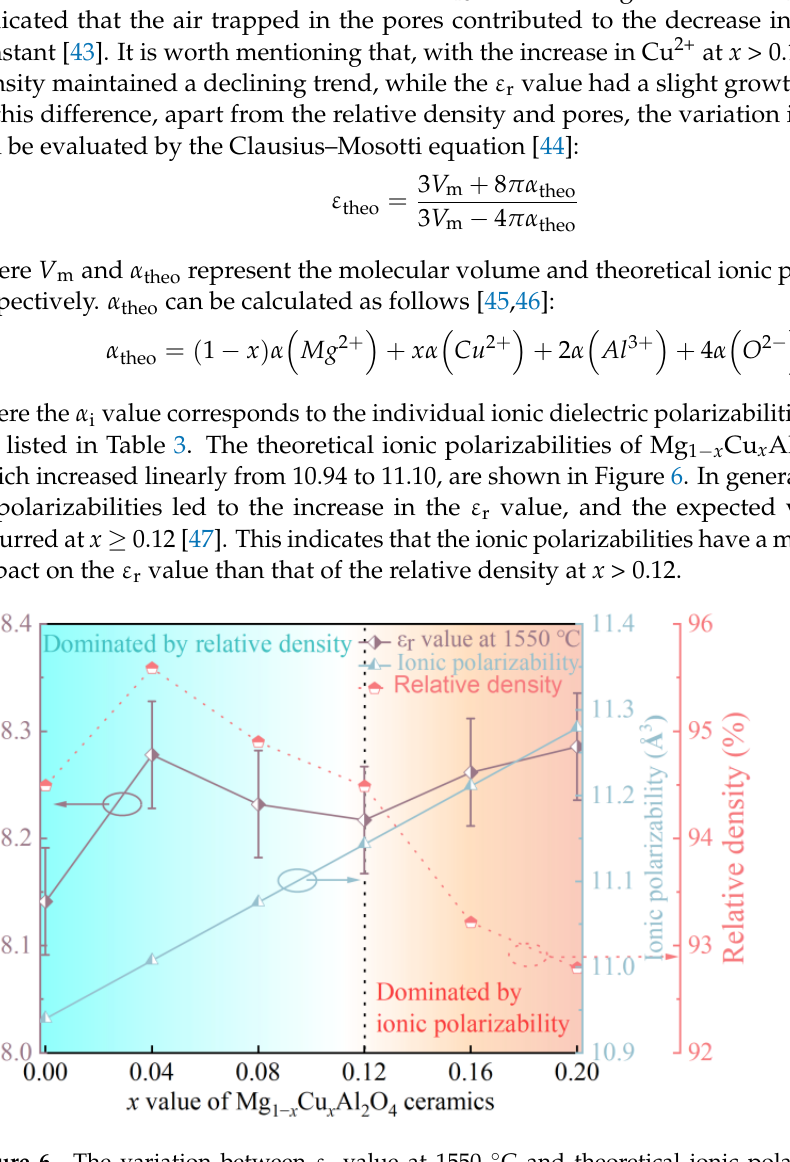
Figure 6. The variation between ε r value at 1550 °C and theoretical ionic polarizabilities; the relative density. Table 3. Measured dielectric constant ( ε r ) and porosity-corrected dielectric constant ( ε rc ) of Mg 1 − x Cu x Al 2 O 4 ceramics sintered at 1550 °C.